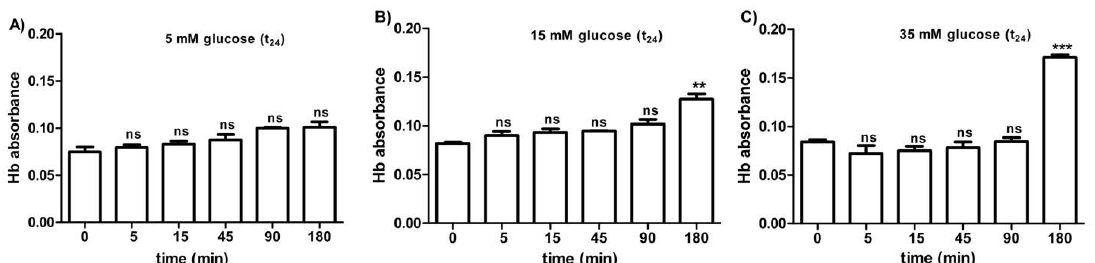
Figure 5. Osmotic fragility measured as hemoglobin (Hb) absorbance (optical density) in erythrocytes after treatment for 24 h with 5 mM glucose (t 24 ) ( A ), 15 mM glucose (t 24 ) ( B ), and 35 mM glucose (t 24 ) ( C ). ns (not significant) versus different time intervals (5-15-45-90-180 min); ** p < 0.01 and *** p < 0.001 versus different time intervals at 15 mM glucose (t 24 ) and 35 mM glucose (t 24 ) as determined by one-way ANOVA followed by Bonferroni’s post-hoc test ( n = 10).